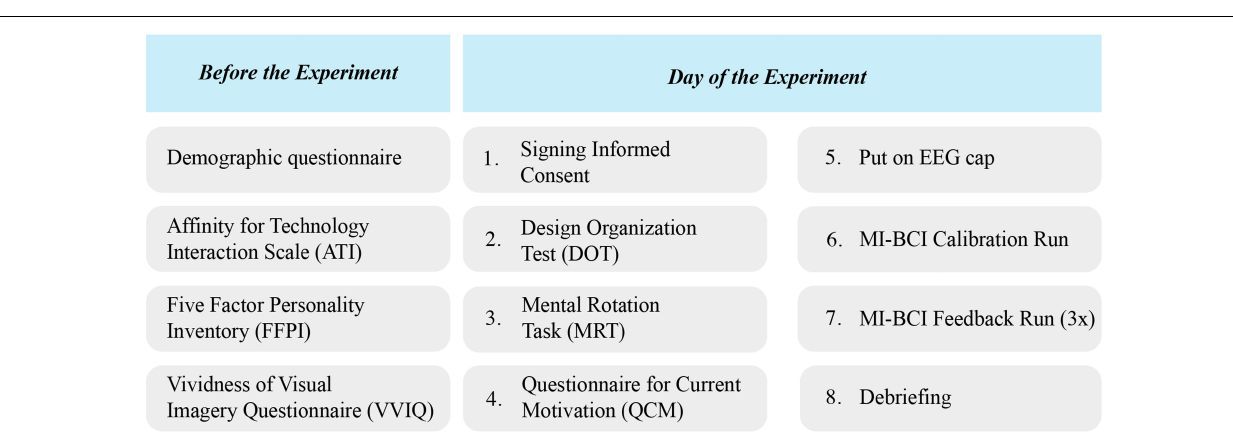
FIGURE 4 | The experimental procedure. Participants completed demographic, ATI, FFPI, and VVIQ questionnaires online before the experiment day. On the day of the experiment, they first completed DOT and MRT tests followed by QCM questionnaire, and then continued to the MI-BCI